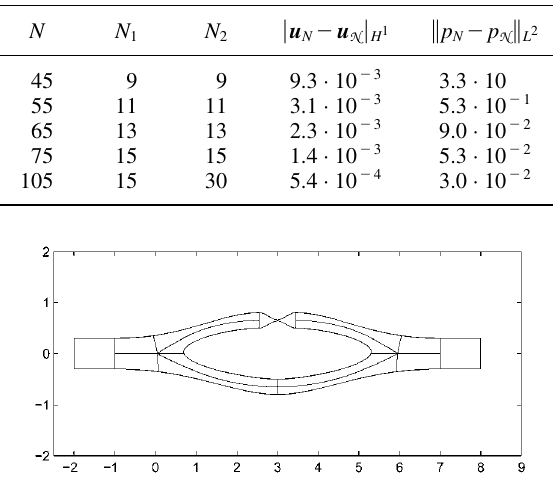
Figure 6. The bypass with three pipe blocks and two bifurcation blocks.